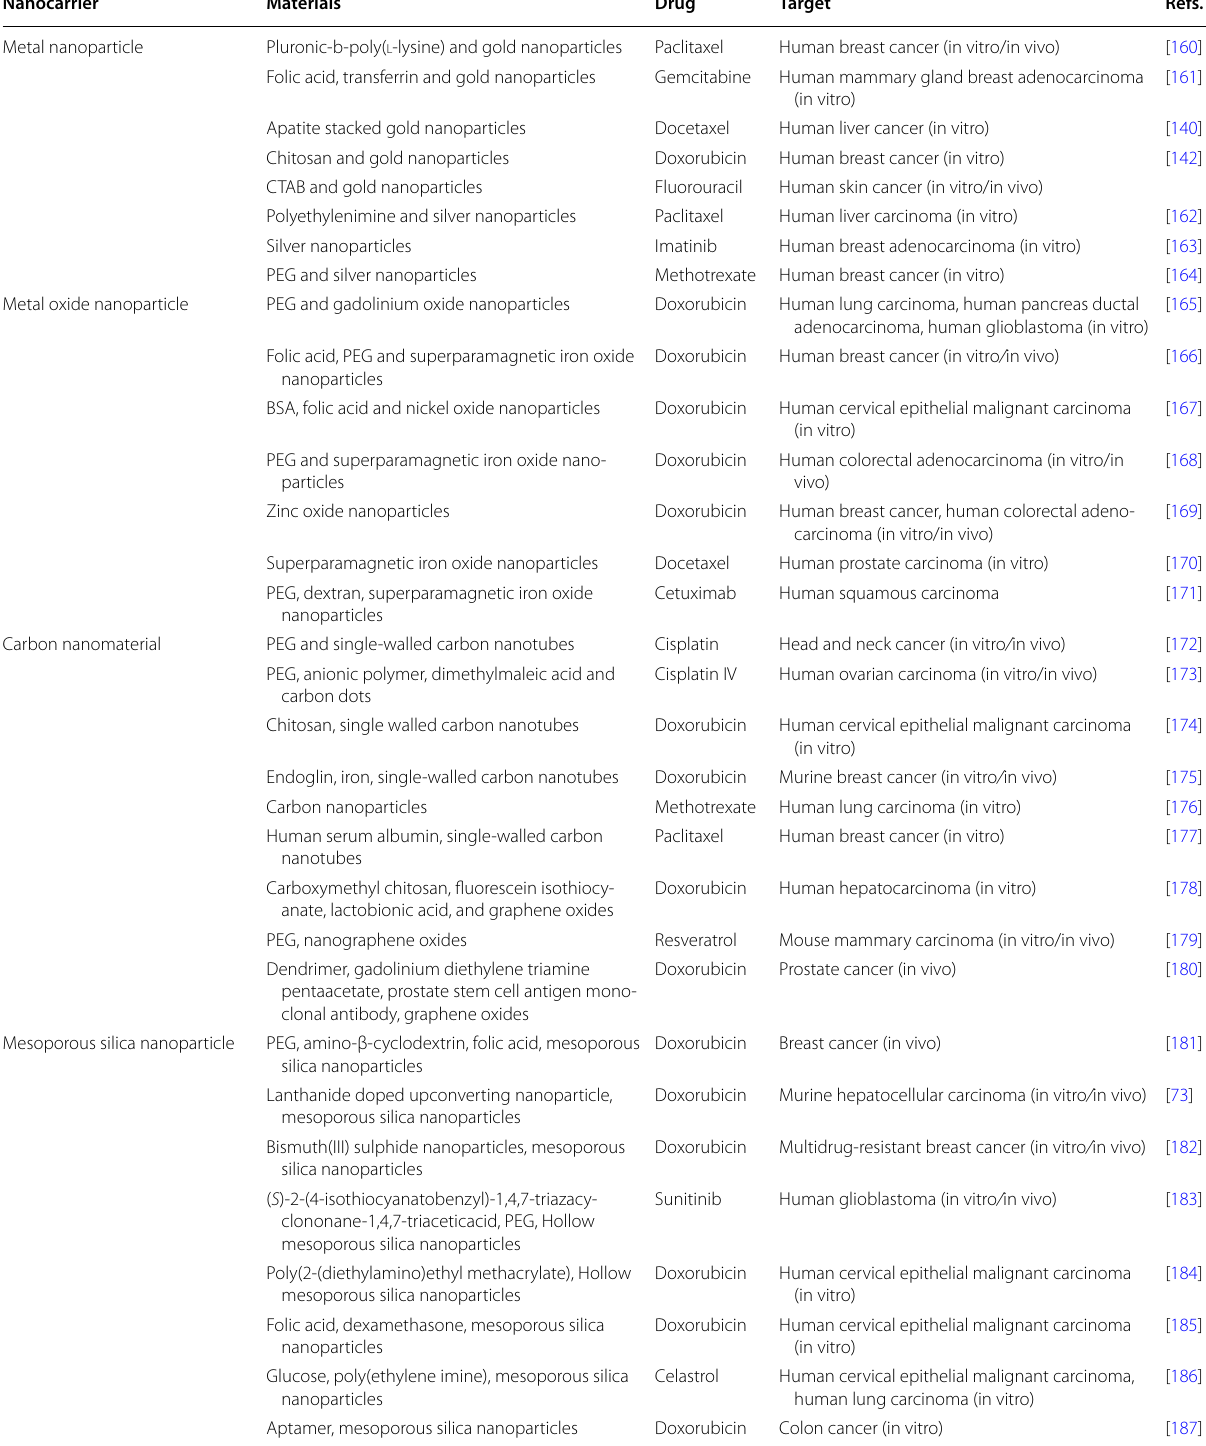
The table illustrates the type of inorganic nanomaterial used as nanocarrier, the drug loaded on the carrier and target site